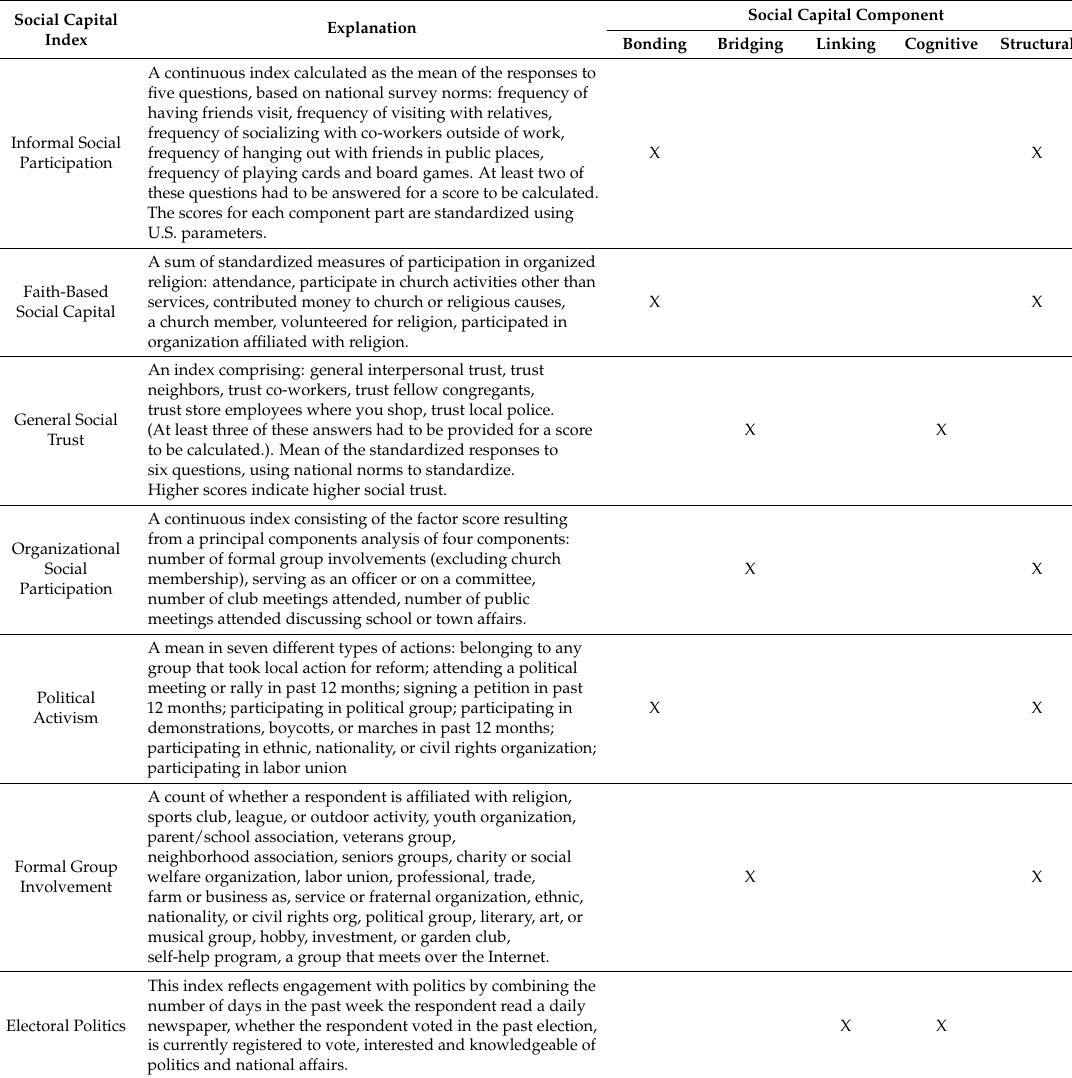
Table 1. Measures of social